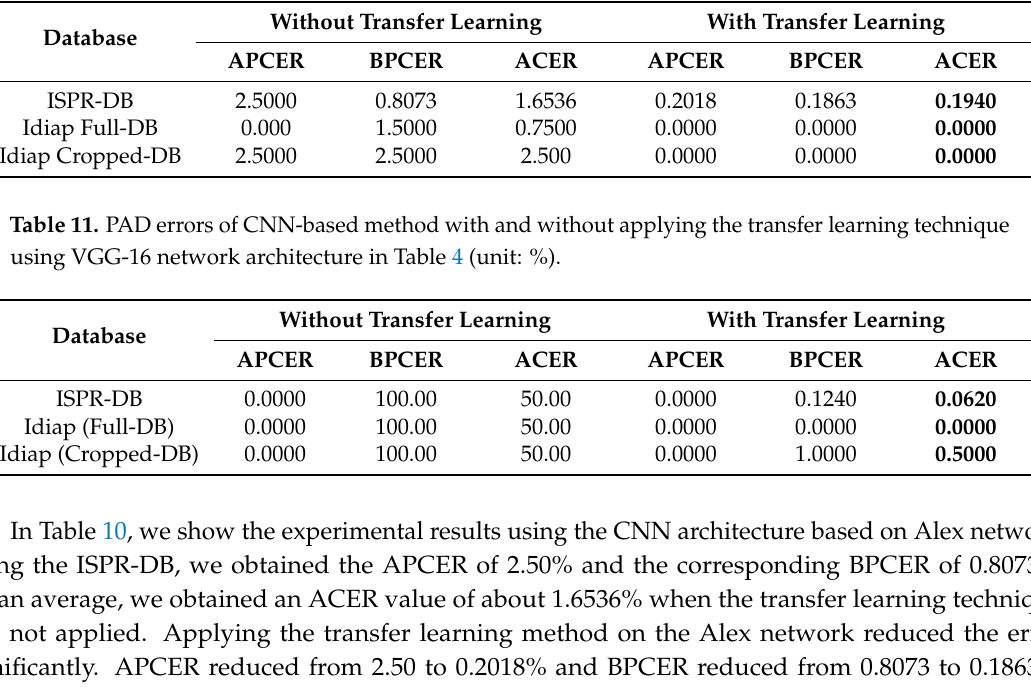
Table 10. PAD errors of CNN-based method with and without applying the transfer learning technique using Alex network architecture depicted in Table 2 (unit: %).